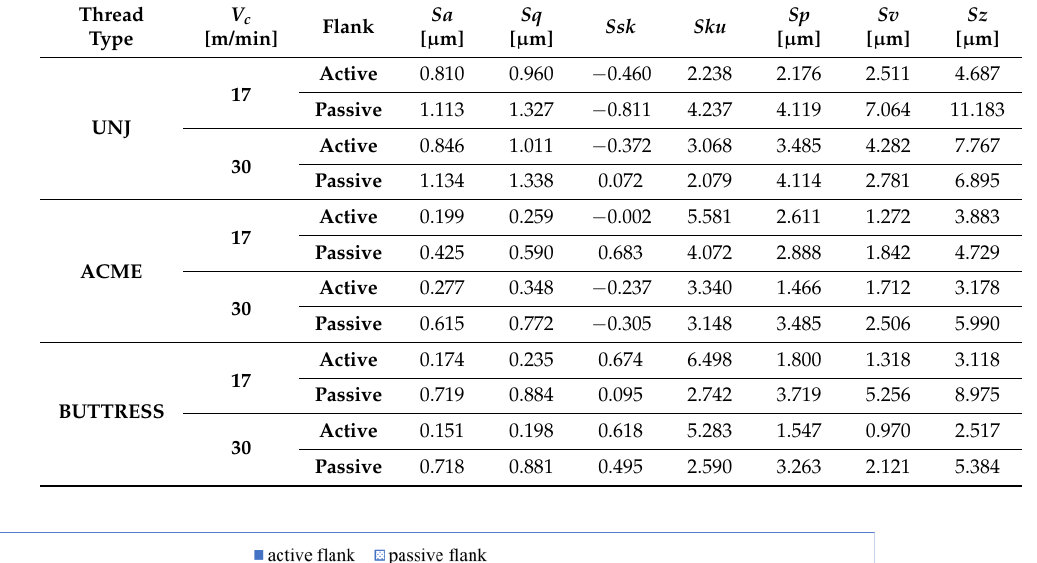
Table 2. Topography measurements results according to ISO 25178-2 [29].